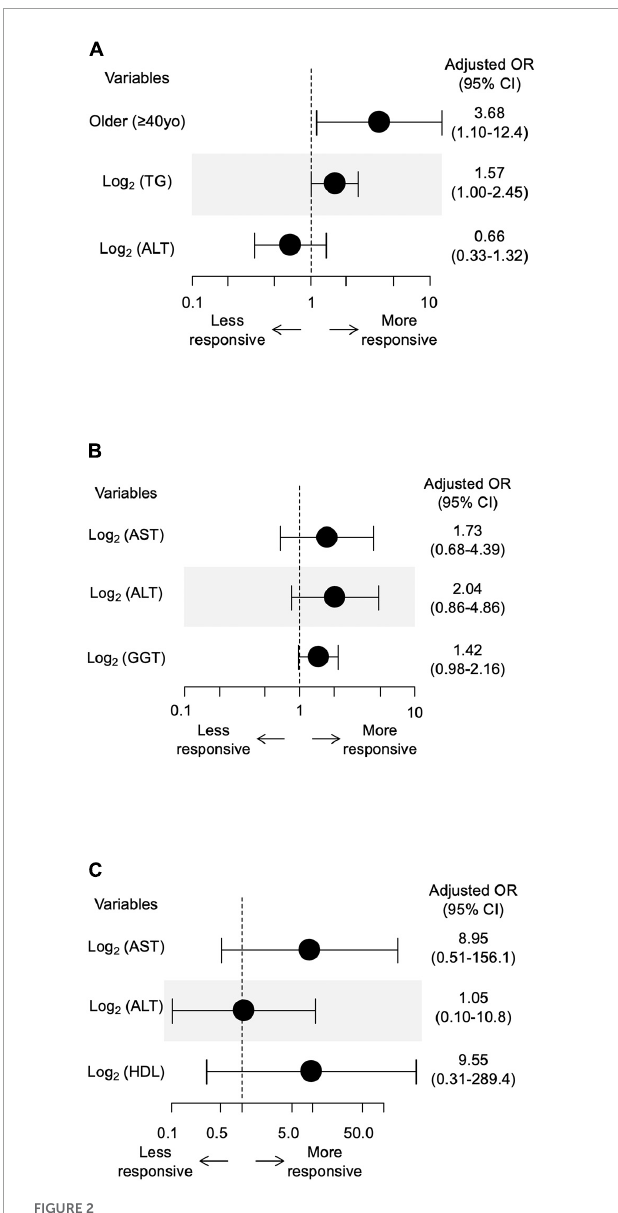
FIGURE2 (A) The associations of normalized ALT after pemafibrate treatment with baseline age, TG and ALT. (B) The associations between 30% decrease in ALT after pemafibrate treatment with baseline AST, ALT, and γ -GTP. (C) The associations between 30% decrease in SWV after pemafibrate treatment with baseline AST, ALT, and HDL-C. TG, triglyceride; ALT, alanine aminotransferase; SWV, shear wave velocity; AST, aspartate aminotransferase; γ -GTP, γ -glutamyl transpeptidase; HDL-C, high-density lipoprotein